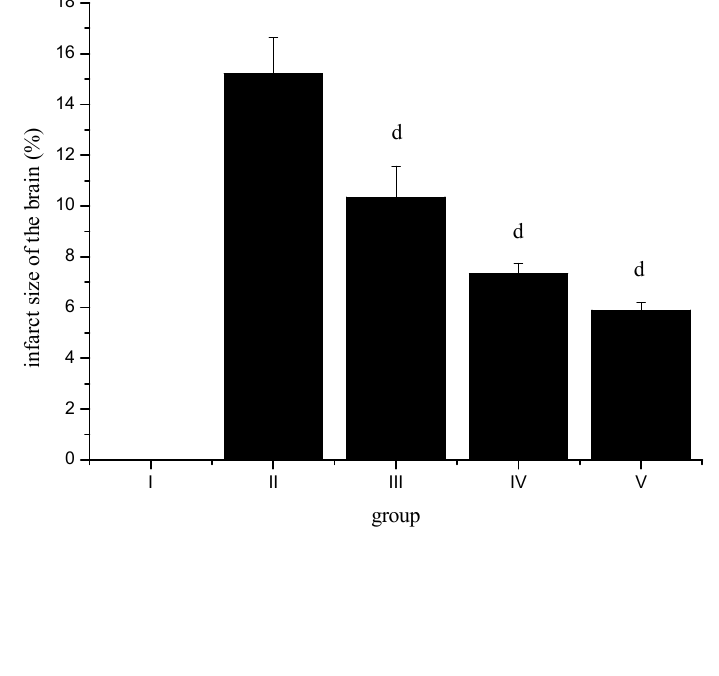
Figure 2. Effect of sevoflurane postconditioning on infarct volume after ischemia-reperfusion. d p < 0.01, compared with group